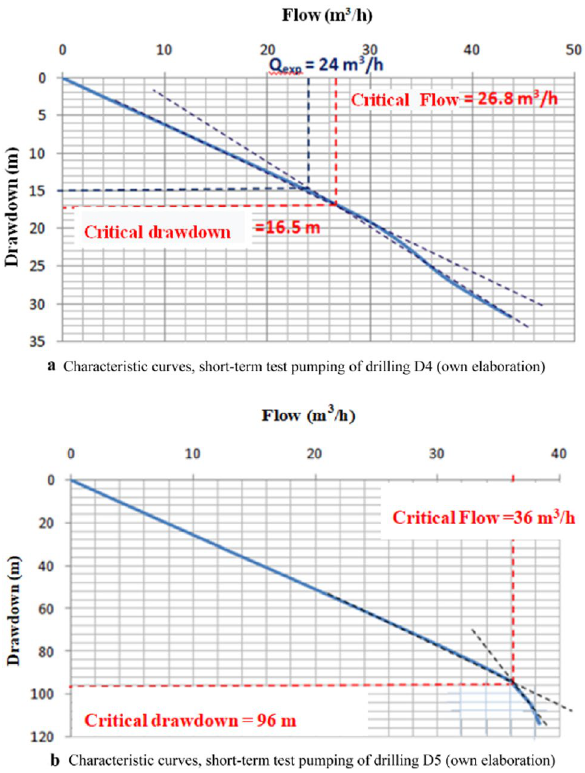
Fig. 8 a Characteristic curves, short-term test pumping of drilling D4